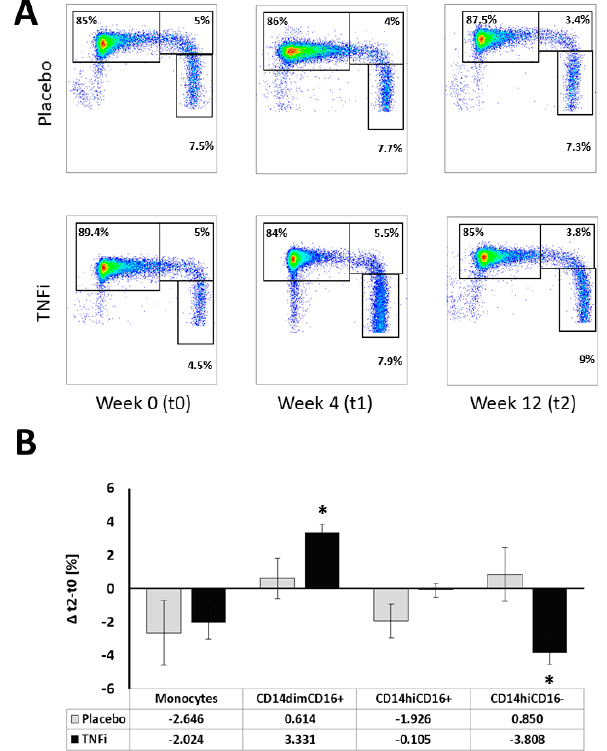
Figure 2. Monocytes and their subpopulation content in placebo and TNFi groups. ( A ) Representative flow cytometric dot plots for placebo and TNFi treated groups at week 0 (t0), 4 (t1) and 12 (t2). Panel ( B ): Mean monocyte content and their subpopulation distribution was calculated as a delta t2 − t0. Error bars represent SEM; * p < 0.05. Table 2. Subpopulations of monocytes and their activation markers in different time t0, t1 and t2 in placebo and anti ‐ TNF ‐α treatment.